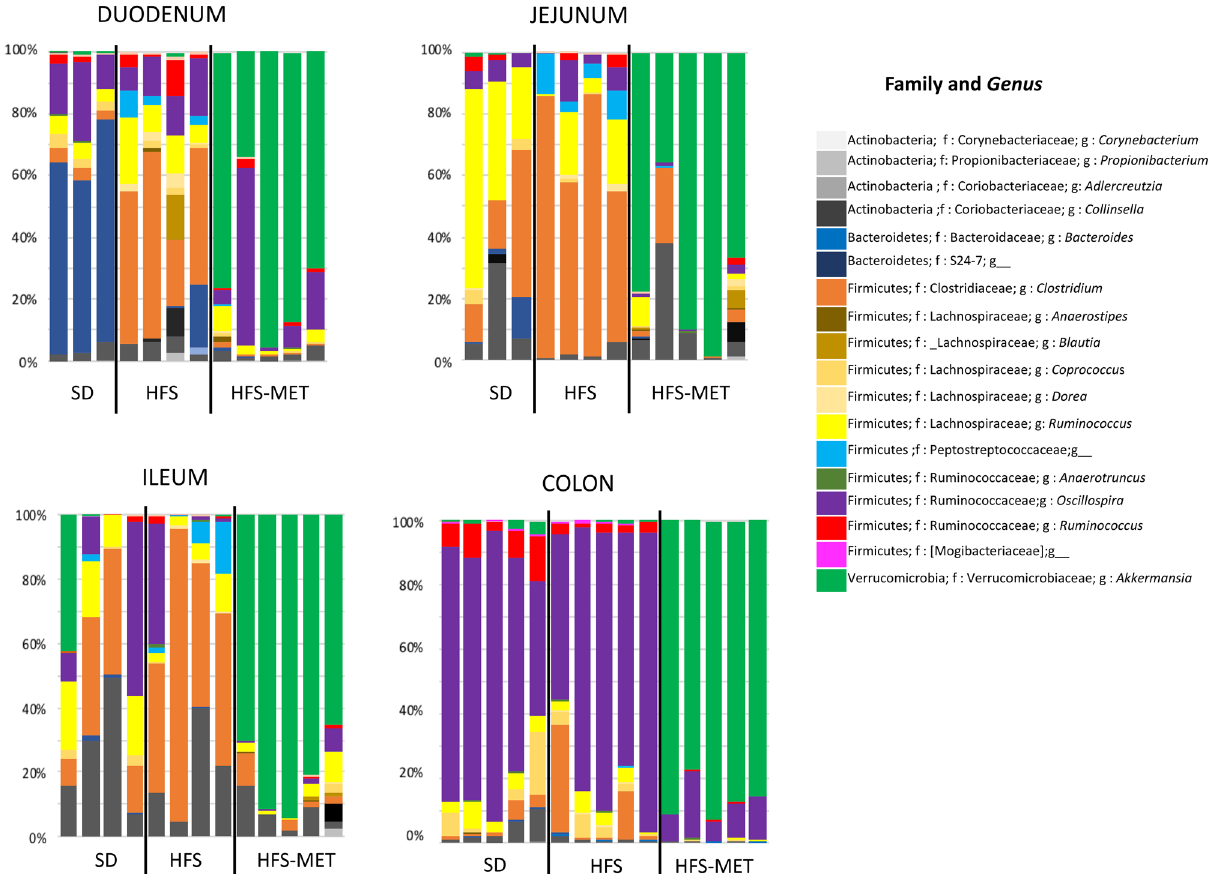
Figure 8. Metformin induces changes of the luminal microbiota composition in the different region of the intestine. Microbiota composition was determined by 16S rRNA sequencing in luminal samples form the duodenum, jejunum, ileum and colon of animals of the 3 groups ( SD standard diet, HFS high fat high sucrose diet, HFS-MET HFS diet with metformin supplementation). The figure represents the relative abundance of the main measurable bacterial families and genera in the luminal samples of individual